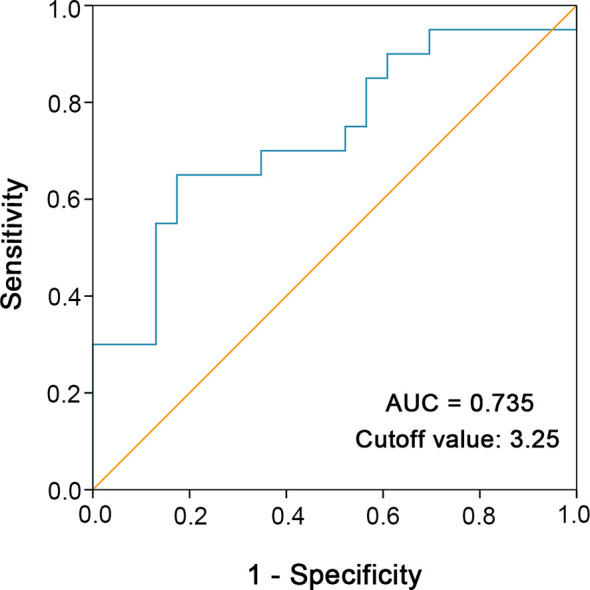
ROC curve analysis was performed to determine the optimal cutoff value of preoperative blood neutrophil to lymphocyte ratio. The sensitivity and specificity for the status of cancer-specific survival were plotted.